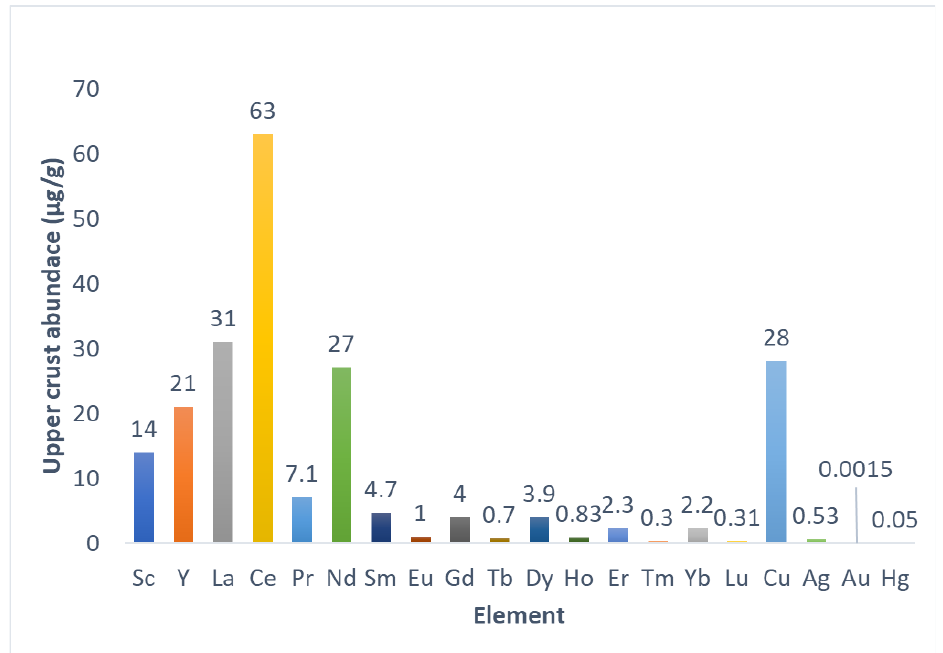
Figure 1. Abundance of REEs and semiprecious and precious metals in the earth’s upper crust. The graph was tabulated using information from [1]. graph was tabulated using information from